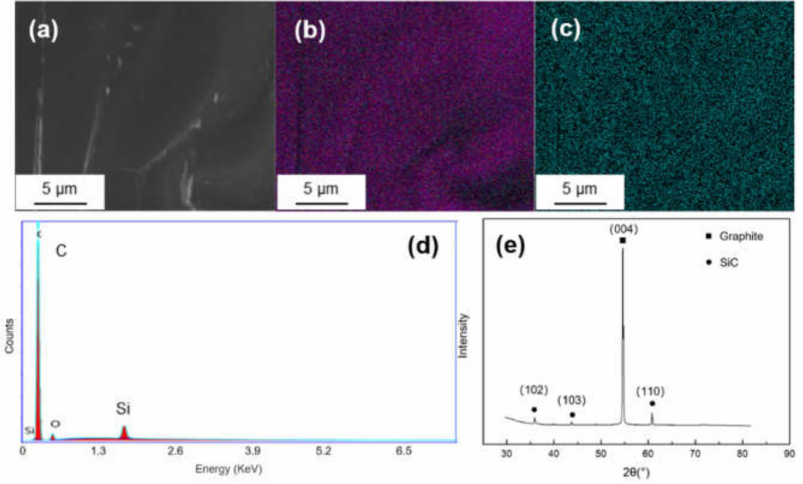
Figure 3. ( a ) SEM morphology and of Ti-coated graphite; ( b , c ) EDS mapping results of C and Si; ( d , e ) EDS spectrum and XRD pattern of the Si-coated